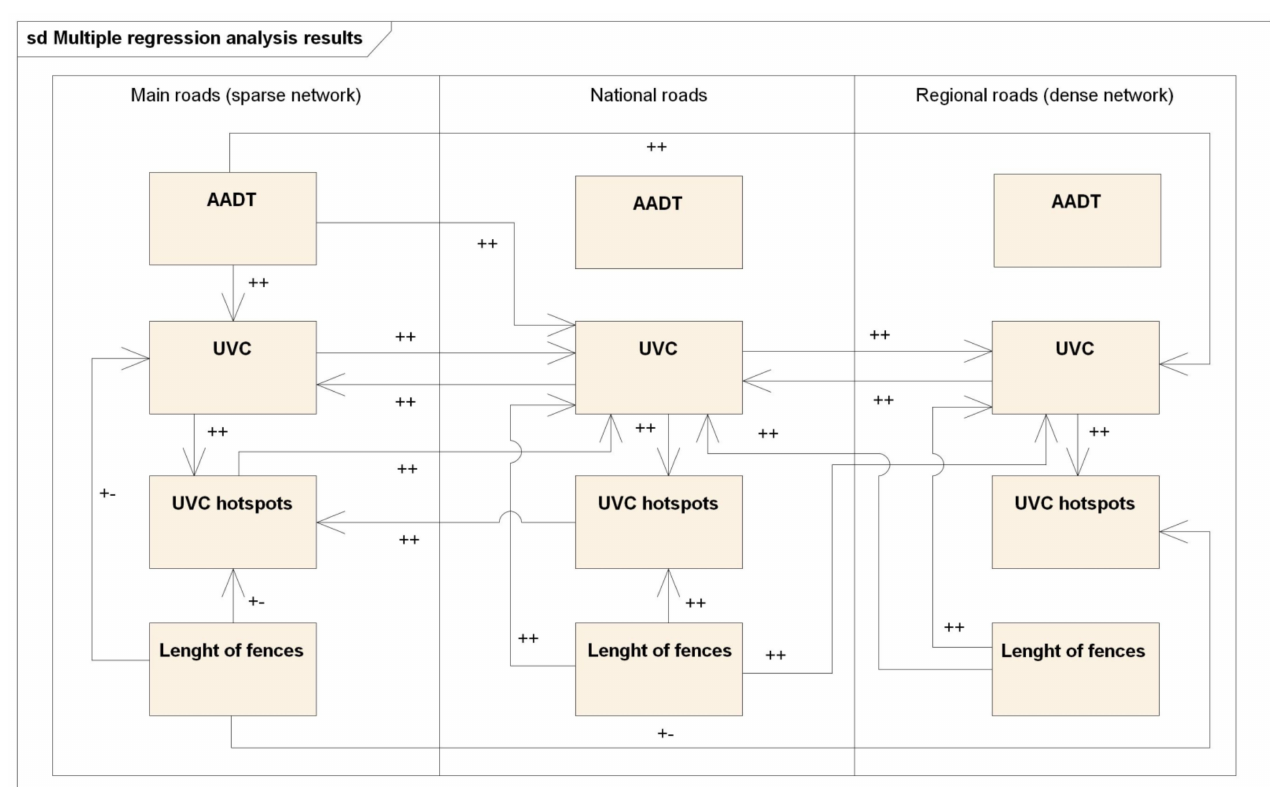
Figure 6. Unified modelling language (UML) collaboration diagram that shows MLR analysis